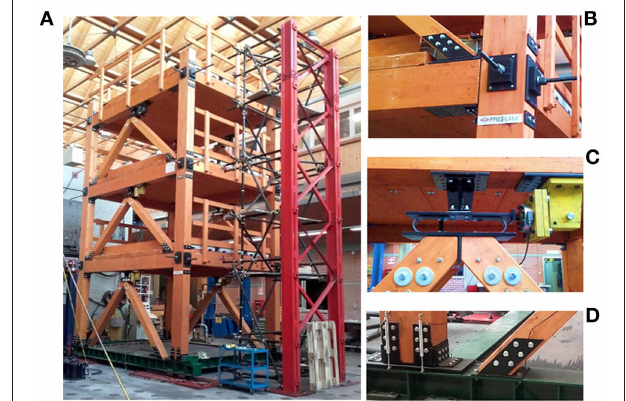
FIGURE 4 | (A) Experimental model of post-tensioned timber frame building with dissipative V-inverted bracing systems. Details of bracing connections to (B) beam-column joint; (C) UFP and beam; (D)